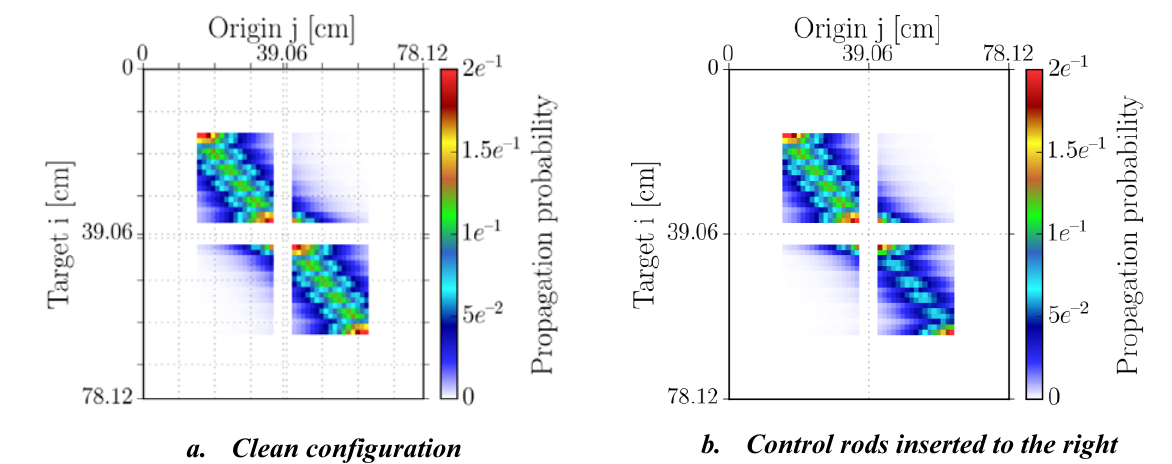
Figure 5. M N matrices for the a water blade width of 5.04cm, showing the effect of rod O P O